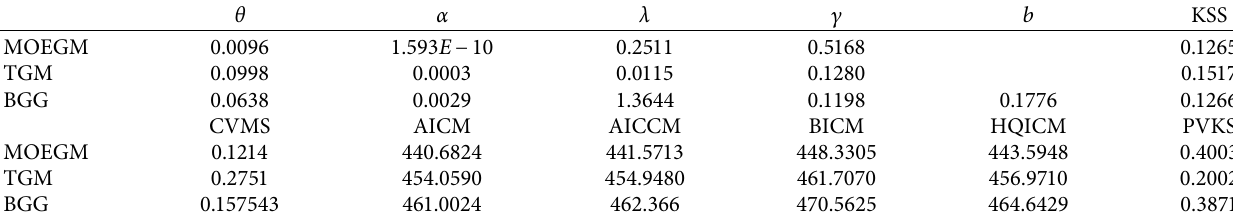
Table 6: Comparison between MOEGM, BGG and TGM distributions:stochastic processes